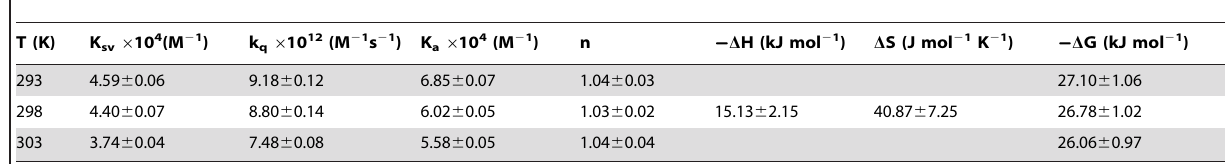
Table 1. 1,2 - Bis(2-Benzimidazolyl) 1,2-Ethanediol interaction and thermodynamic parameters.